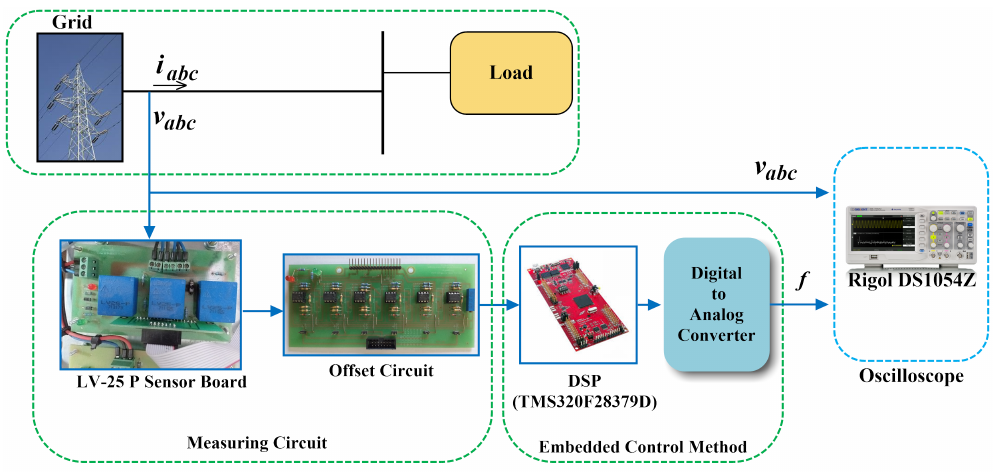
Figure 8. Block diagram of the experimental setup.